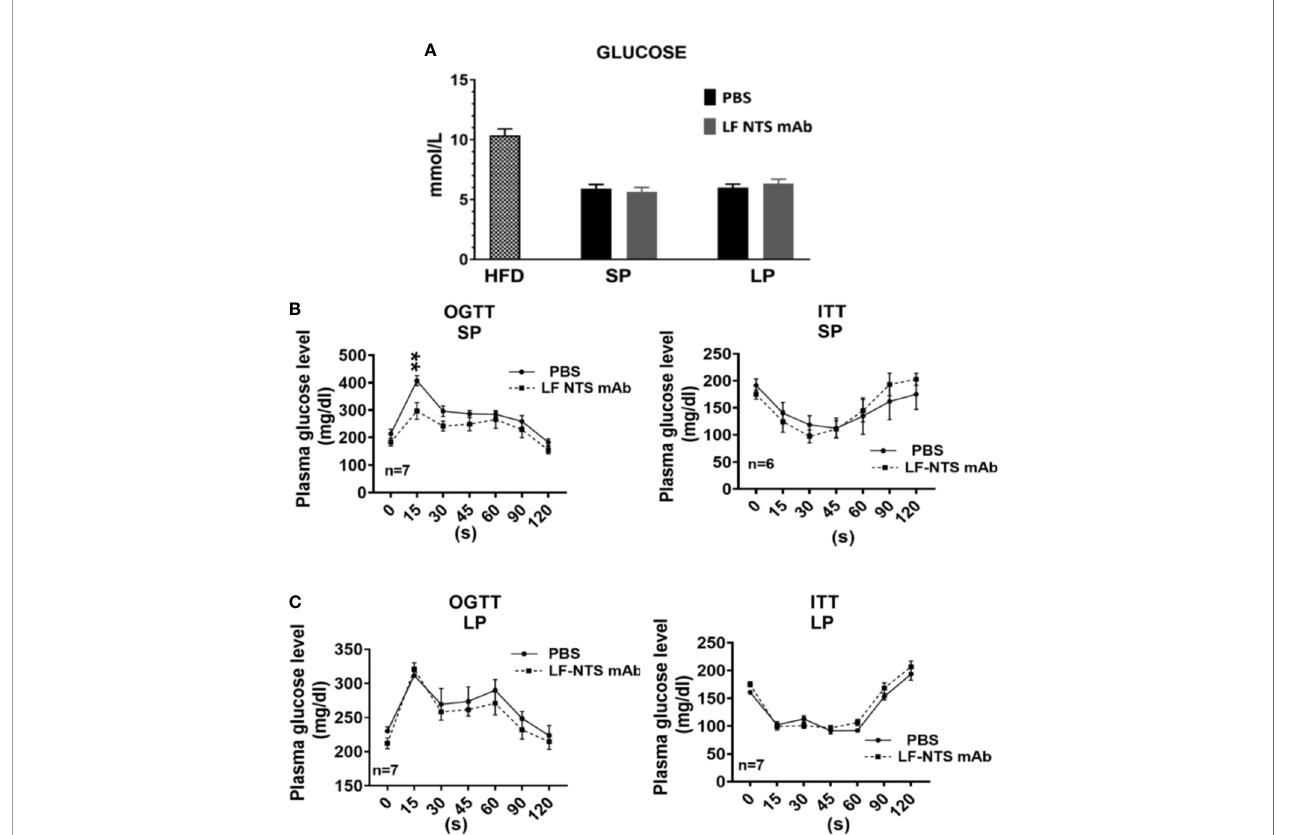
FIGURE 3 | Glucose metabolism. (A) Glucose level were measured in plasma (HFD n = 17, SP n = 21, LP n = 10). Insulin tolerance test (ITT) and oral glucose tolerance test (OGTT) were performed during the SP (B) and LP (C) at 8 days apart. See details in the method section 2 way ANOVA **p <